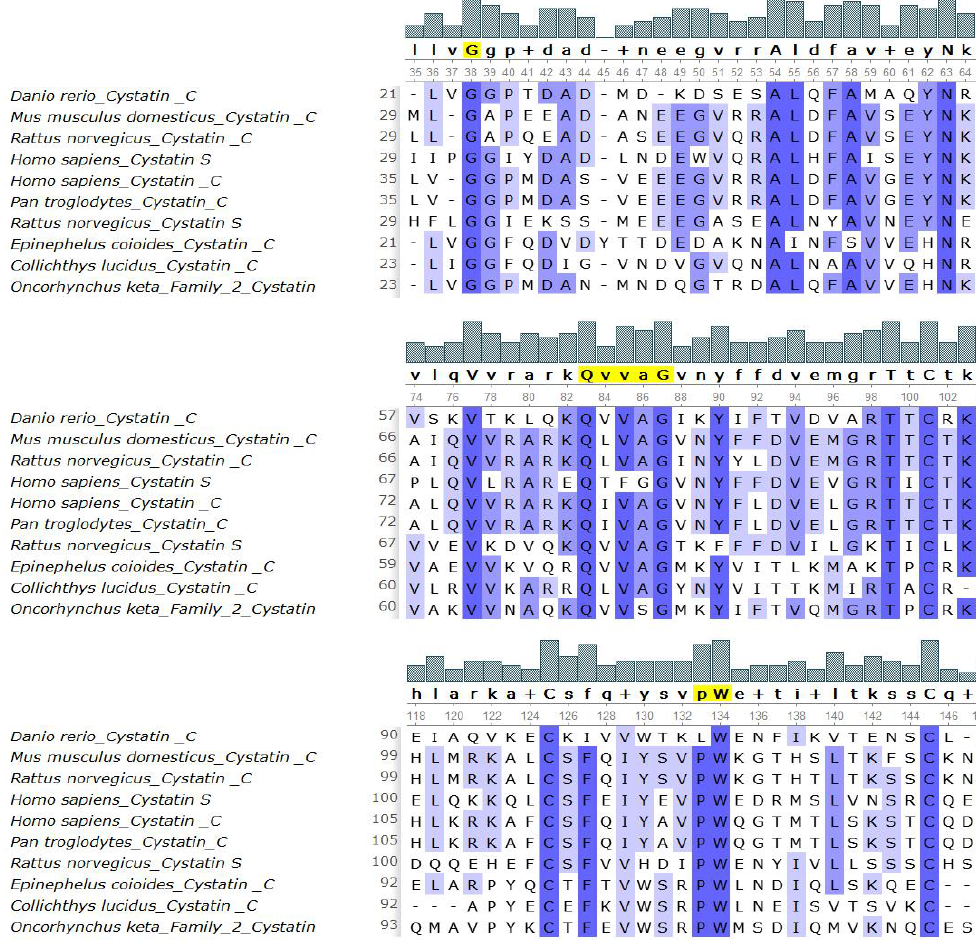
Figure 3. Alignment of the Danio rerio amino acid sequence with the closely related sequences. The conserved G, QVVAG, and P.W. motifs are highlighted in yellow. Highly conserved, strong homologies are shaded in dark blue, and weak similarities are shaded in light blue.